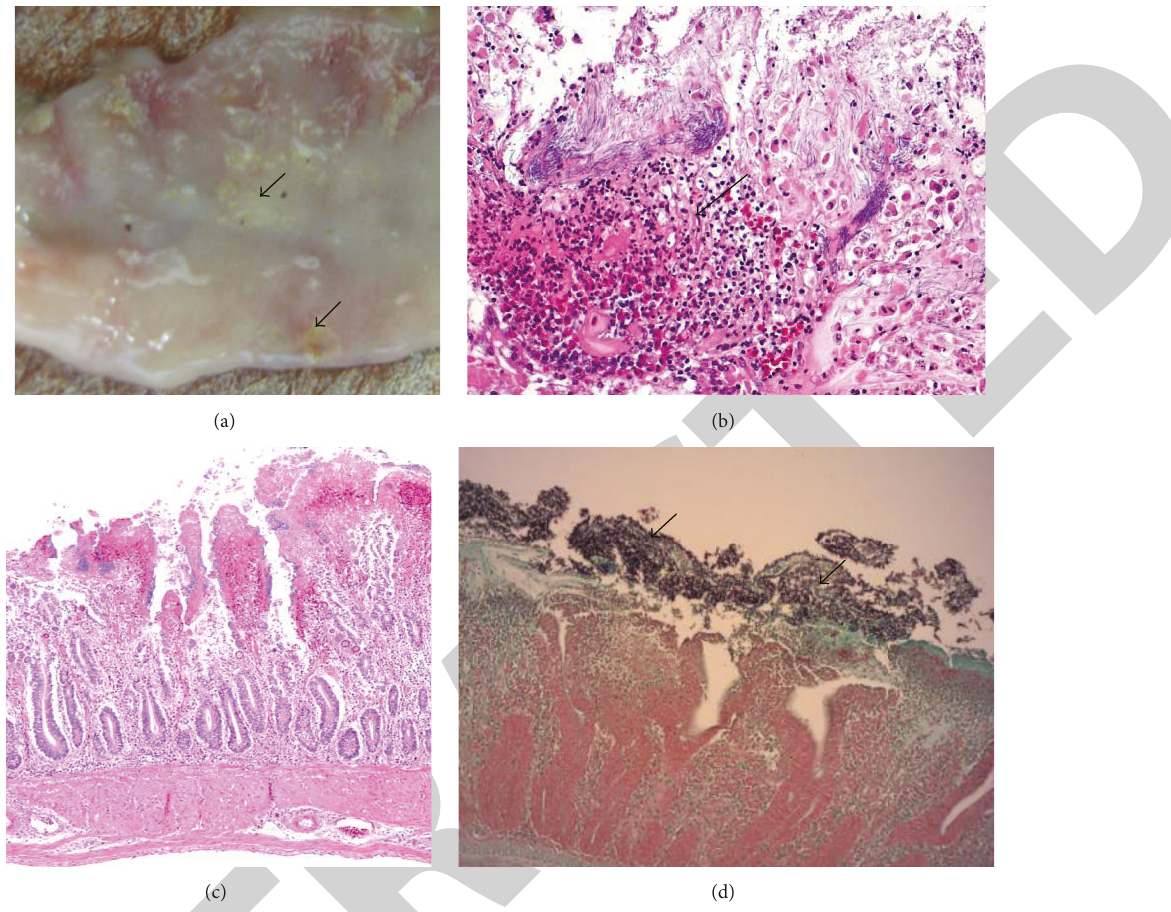
Figure 2: Turkeys of group D ( C. perfringens 10 8 CFU/turkey plus wheat based diet) show lesions: (a) focal necrosis and fibrin accumulation in the lumen of intestine, (b) focal necrosis in duodenum, (c) necrosis of apical portion of villi with fibrinonecrotic exudate associated with large number of rod shaped bacteria, and (d) necrotic villi and presence of fibrin like material in the lumen and aggregation of Gram-positive bacilli clustered around necrotic villi. Table 4: Effect of C. perfringens on blood profile picture of turkeys (mean ± SD) on day 7 after infection (day 35 after hatch). Blood profile